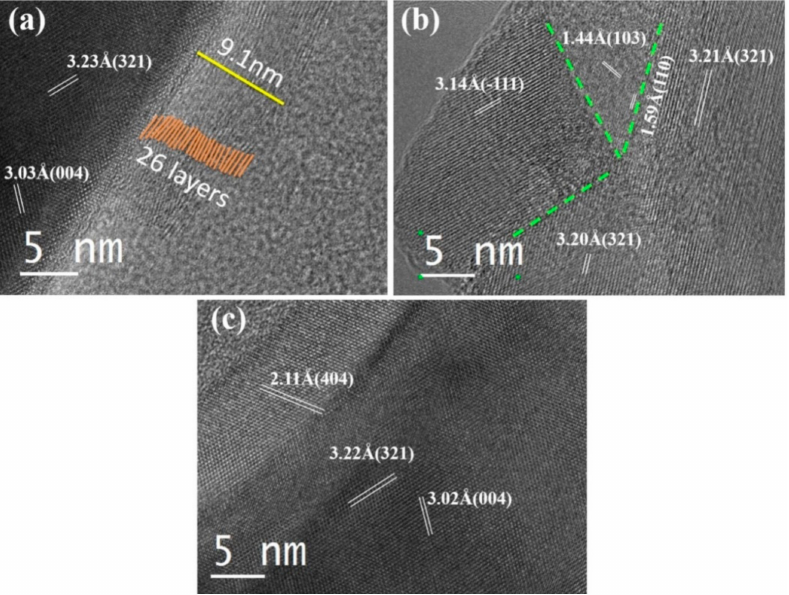
Figure 2. High-Resolution Transmission Electron Microscopy (HRTEM) images for C@YAG:Ce 3+ ( a ); C@YAG:Ce 3+ -1500 ◦ C ( b ) and C@YAG:Ce 3+ -1650 ◦ C ( c